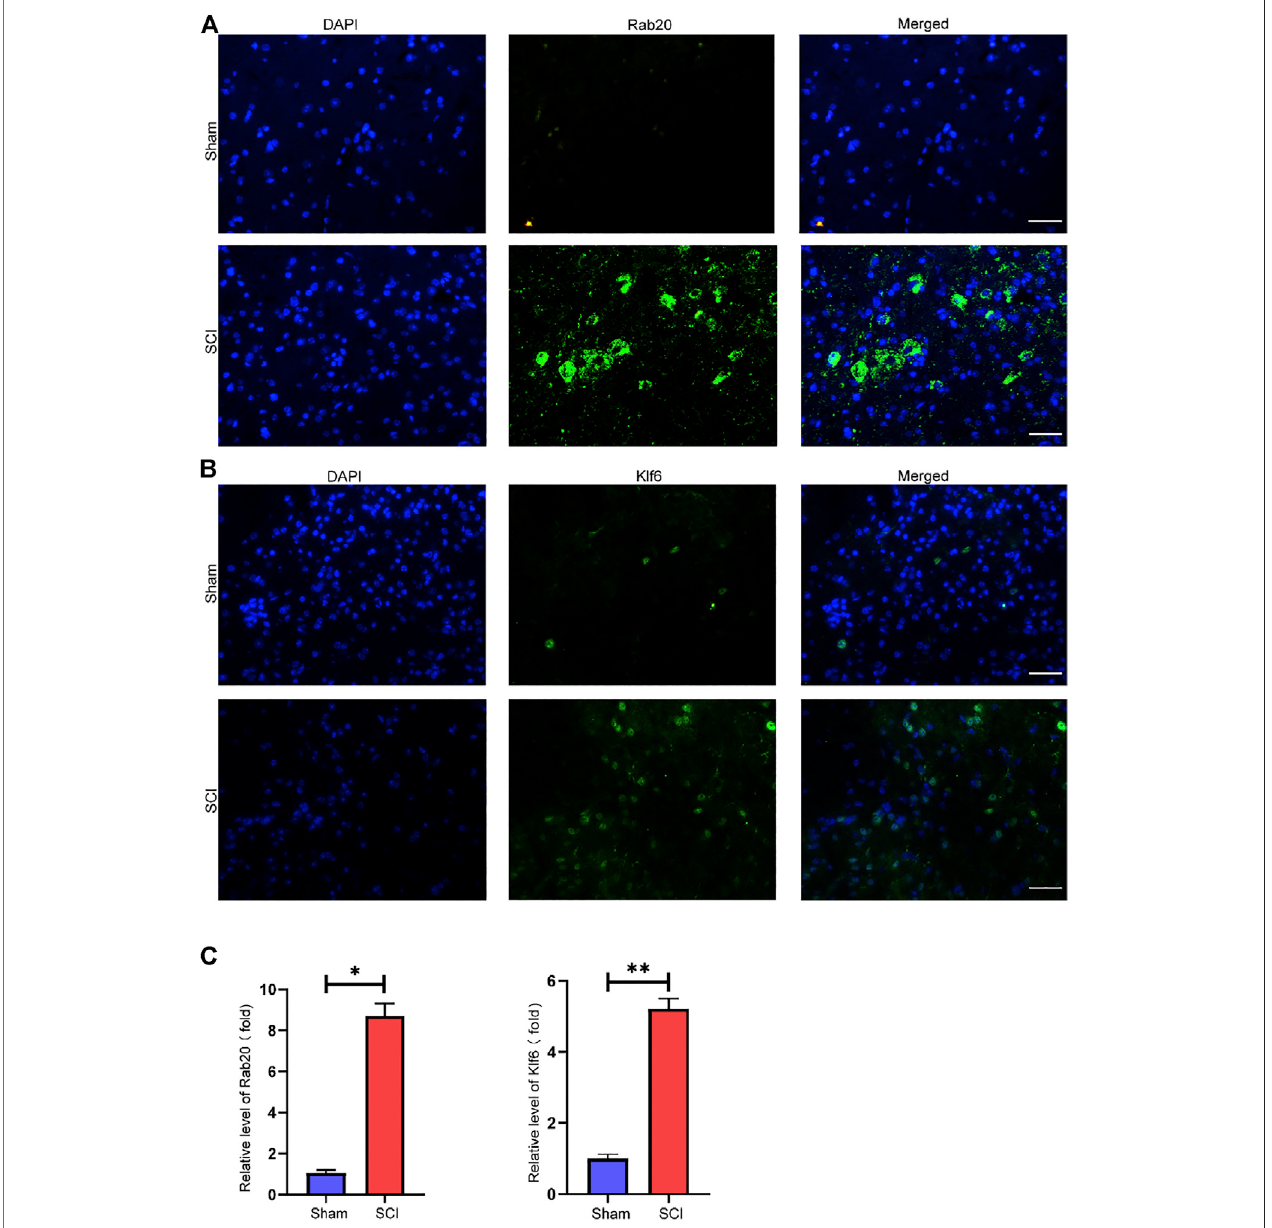
FIGURE 5 | Key genes validation. (A) Representative images showed that Rab20 expression was examined using immuno fl uorescence. (B) Representative images showed that Klf6 expression was examined using immuno fl uorescence. (C) qRT-PCR veri fi cation of Rab20 and Klf6 in SCI samples of mice and sham samples of mice. The results were represented as mean average ± SE with p < 0.05. scale bar represents 100 µM in (A,B) .